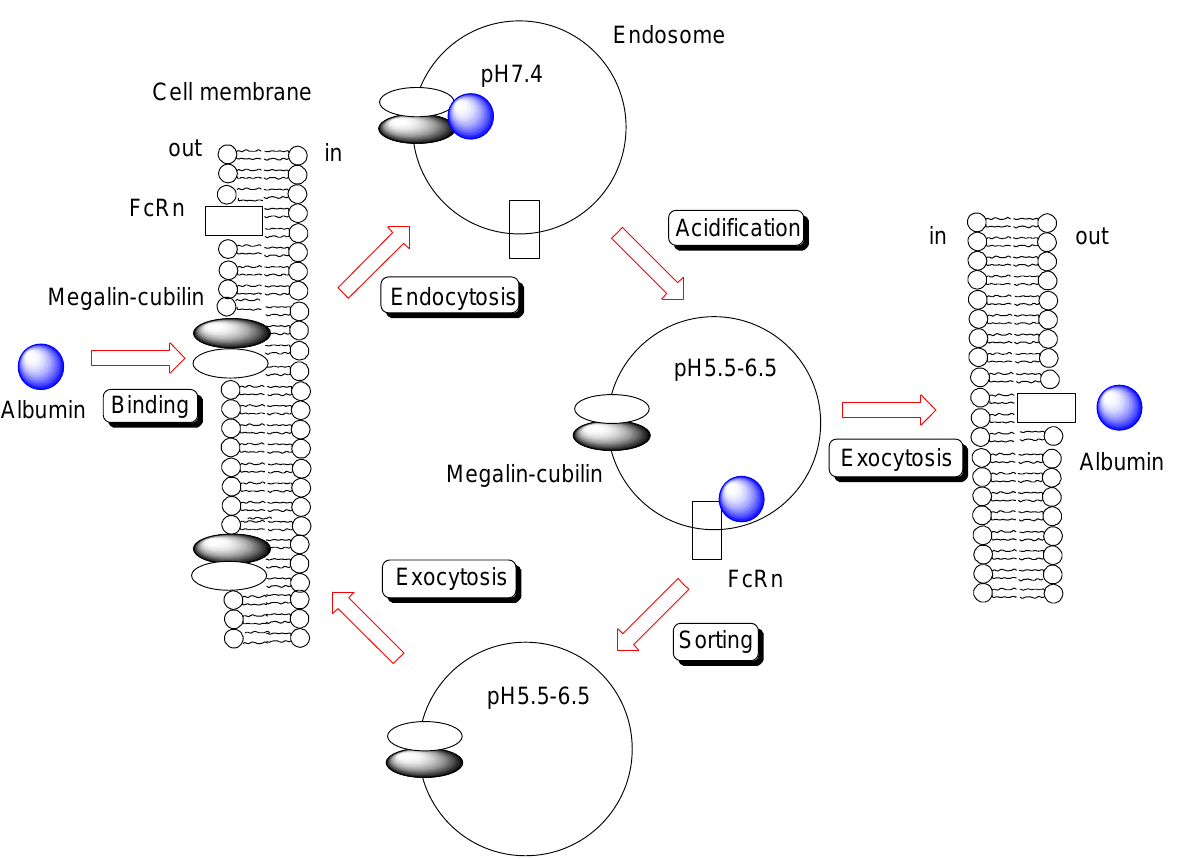
Figure 6. Schematic overview of transcytosis of albumin through megalin–cubilin and FcRn binding.